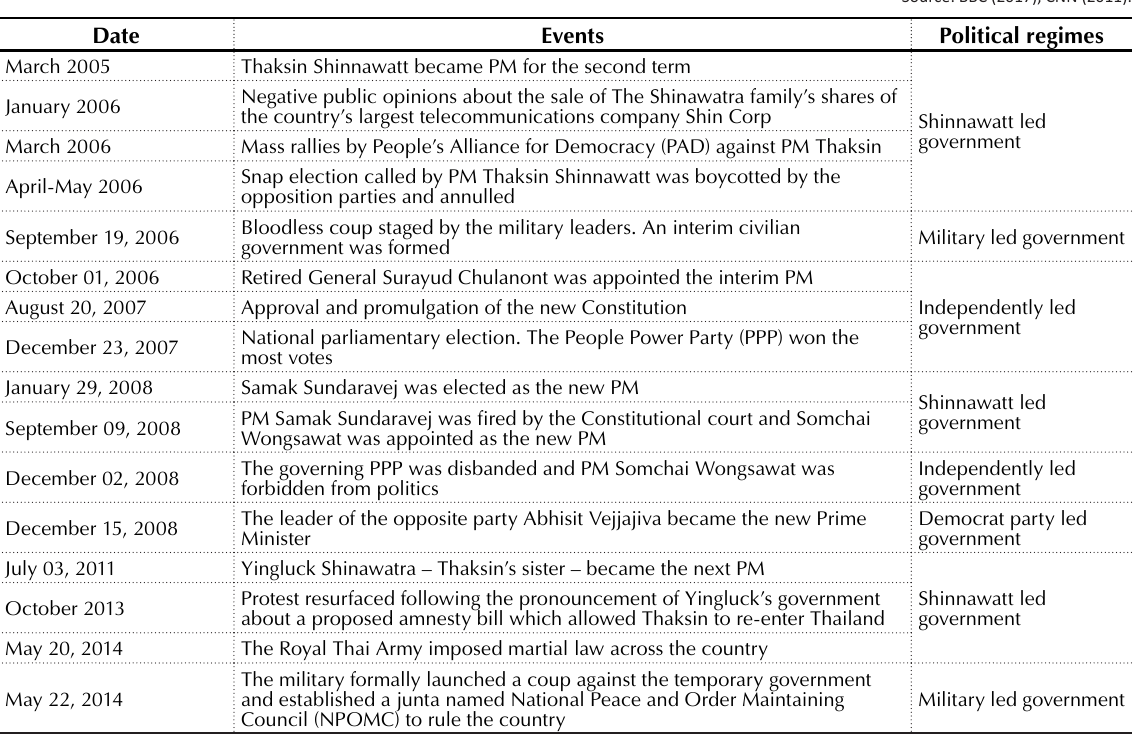
Table 1. Thailand’s key political events (2005 to